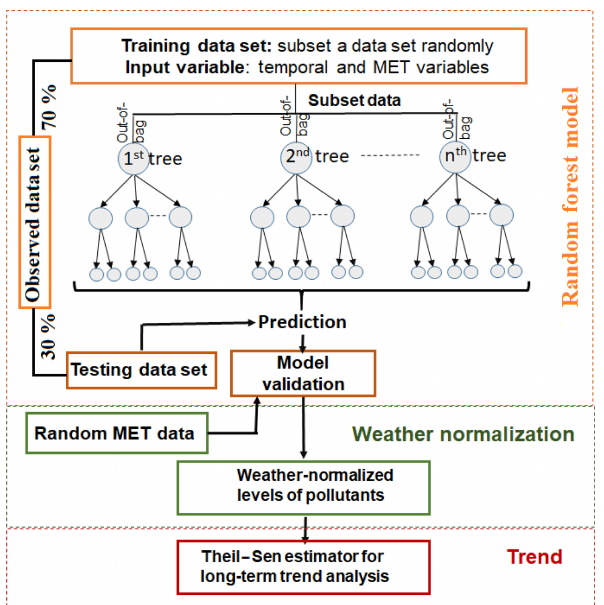
Figure 1. A diagram of long-term trend analysis